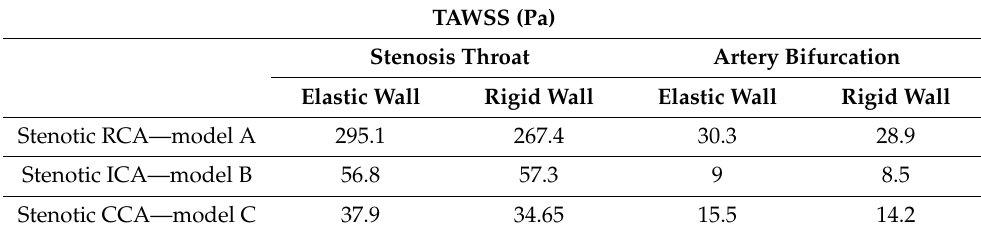
Table 3. TAWSS for the stenotic RCA and CA for elastic and rigid wall.